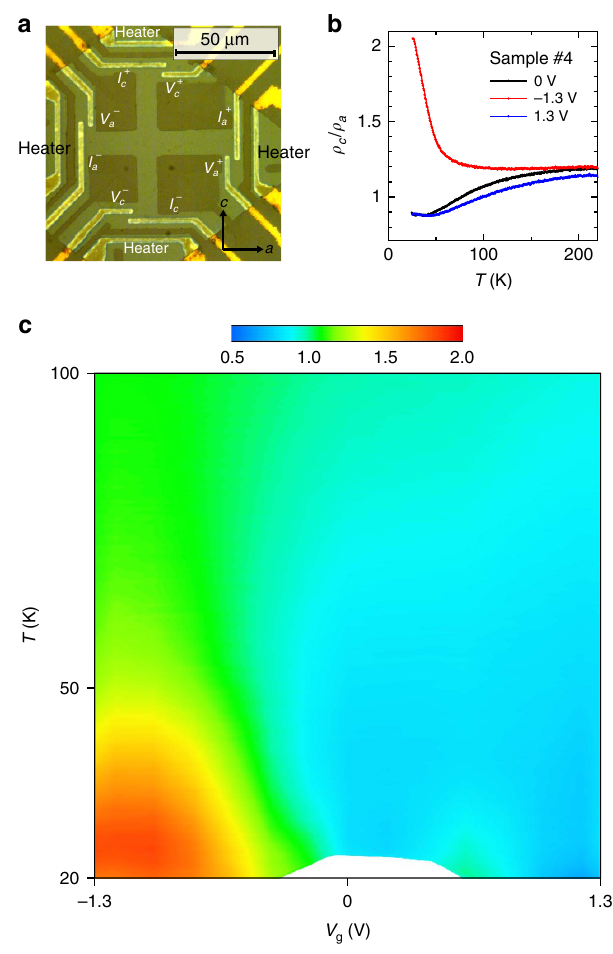
Figure 5 | Anisotropy of the resistivity. ( a ) Optical image of the sample. The crystallographic axes were assigned by the heat measurement because the a axis ( c axis) shows positive (negative) Seebeck coefficient at room temperature. ( b ) Temperature dependence of r c / r a at V g ¼ (cid:2) 1.3, 0 and þ 1.3V. Here, r c ( r a ) is the resistivity along the c axis ( a axis). ( c ) Contour plot of r c / r a as a function of T and V g . The applied gate voltages were (cid:2) 1.3, (cid:2) 1.2, (cid:2) 1, (cid:2) 0.8, (cid:2) 0.6, (cid:2) 0.4, (cid:2) 0.2, 0, 0.2, 0.4, 0.6, 0.8, 1, 1.2 and 1.3V. Data are missing at low temperature and low doping (white region) due to the high